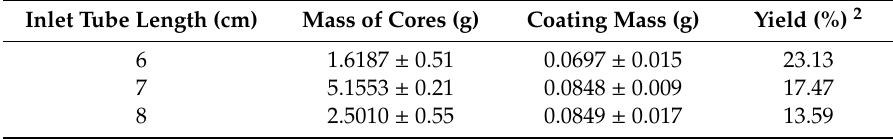
Table 5. Yield of aerosol coating process with di ff erent aerosol inlet tubes 1